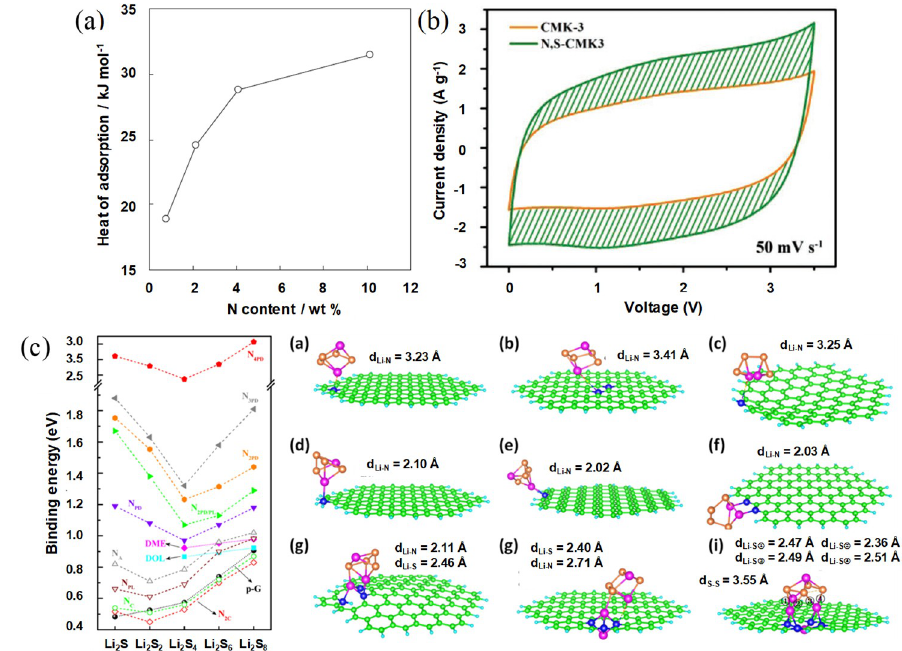
Figure 7. ( a ) Increase of the heat of CO 2 adsorption at a surface coverage of ~0.6 mmol/g with the increase of the nitrogen content of polypyrrole-based porous carbons [24]. ( b ) Cyclic voltammograms of ordered mesoporous CMK-3 and heteroatom-doped CMK-3 carbon electrodes in ionic liquid-based supercapacitors showing that heteroatoms enhance the energy storage [130]. ( c ) Calculated binding energies between lithium polysulfides and N-doped graphenes with different doping configurations as well as optimized molecular structures of Li 2 S 4 on N-doped graphenes [133]. ( a ) adapted from [24], with permission from Wiley, 2011; ( b ) adapted from [130], with permission from Wiley, 2018; ( c ) reproduced from [133], with permission from Elsevier, 2016.